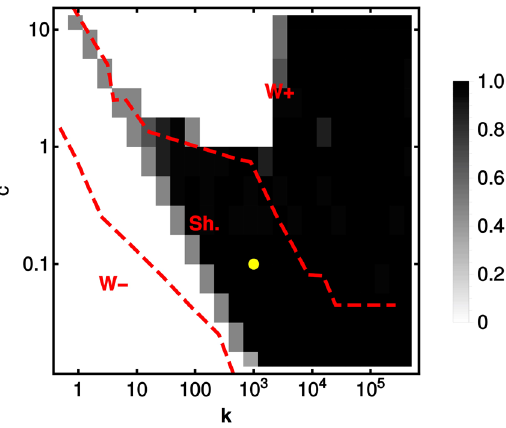
Figure 3. Phase portrait of the spatial model in the space spanned by the blood-tissue turn-over rate k and nutrient availability c . Asymptotic value of the fraction φ of aberrant cells (color coded) as a function of the turn-over rate τ ≡ − k 1 and of the level c of primary nutrient in the blood. Dashed red lines delimit regions with qualitatively different roles for the waste. In region labeled W − no waste is secreted; in region Sh., waste secretion by aberrant cells occurs coupled with waste recycling by healthy cells; in region W + , waste secretion but no re-cycling takes place. Simulations are carried out in a 20 × 20 grid, and results are averaged over 20 different runs per point. The yellow dot marks the parameters used in Fig.